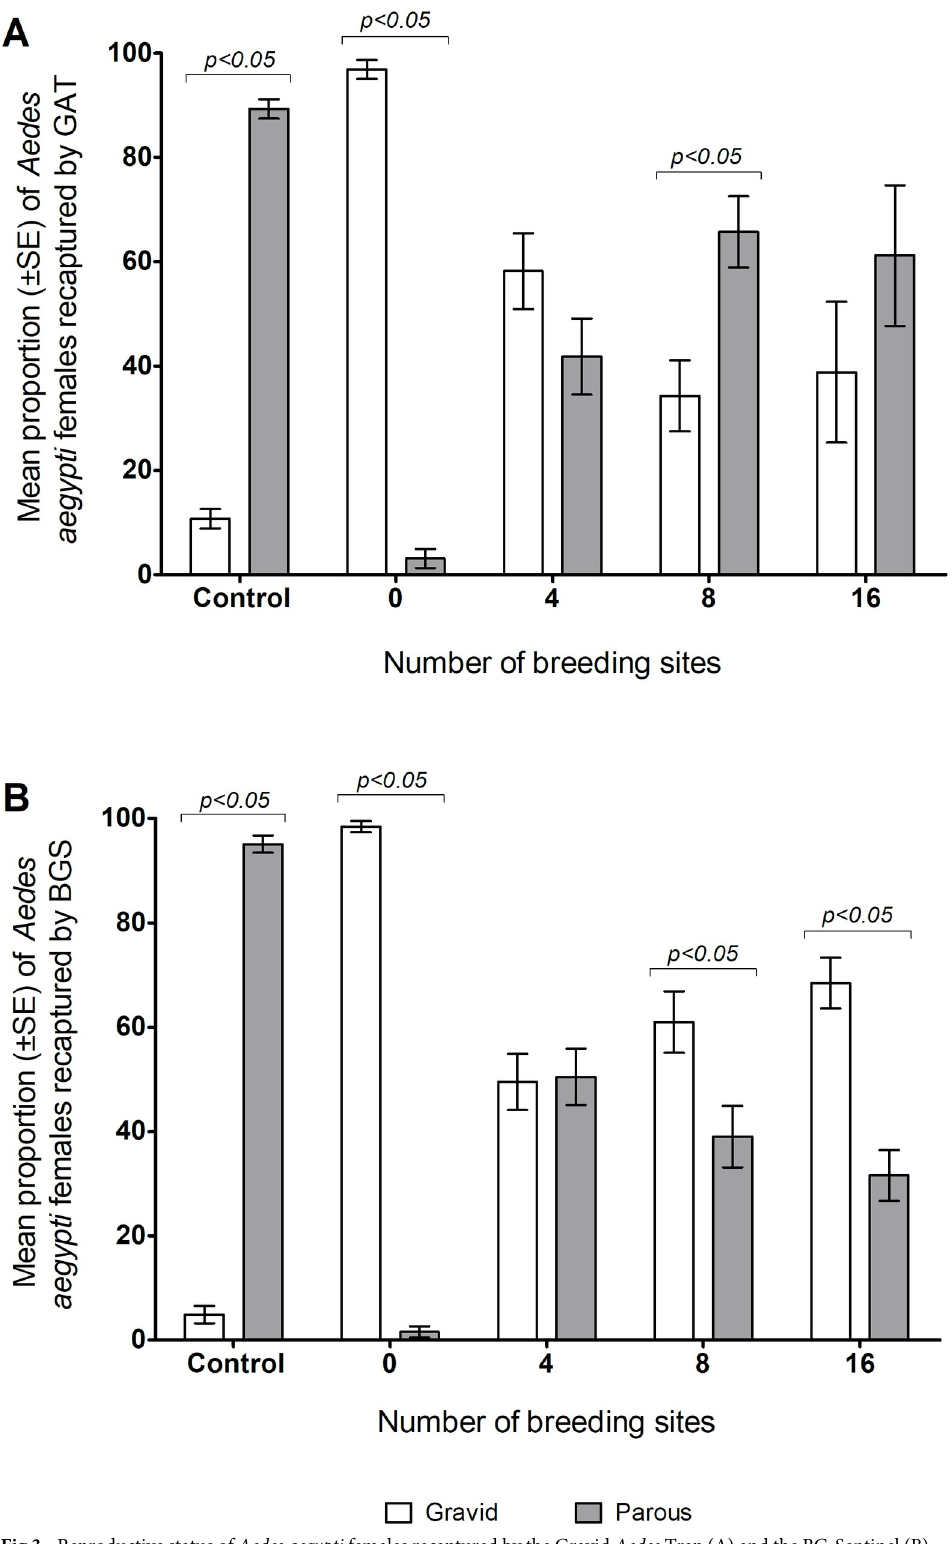
Fig 3. Reproductive status of Aedes aegypti females recaptured by the Gravid Aedes Trap (A) and the BG-Sentinel (B) in a simulated outdoor environment with 0, 4, 8 or 16 breeding sites per environment. In the control treatments (no